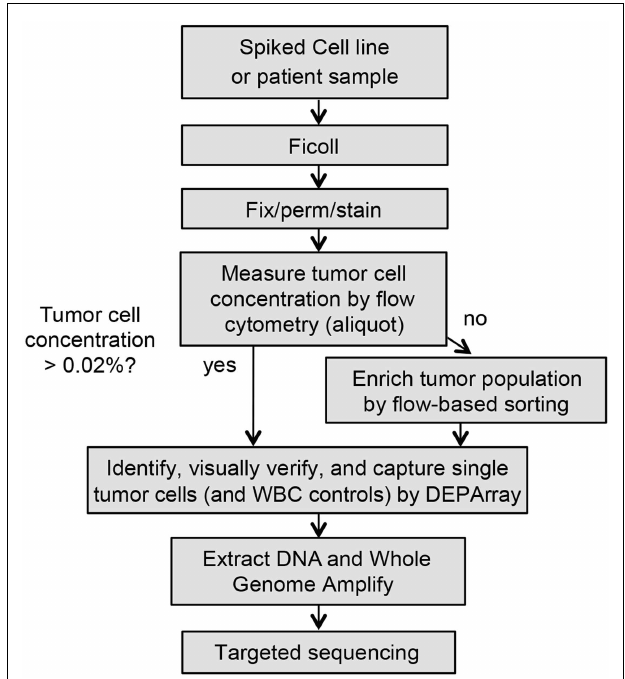
FIGURE 1 |Workflow for rare single cell isolation by DEPArray . Shown are the steps for dielectrophoretic isolation and downstream genetic analysis of single cells. Because the DEPArray cartridge has a capacity of ~40,000 cells, if the tumor cell concentration is below 0.02%, pre-enrichment of the sample is first completed on the